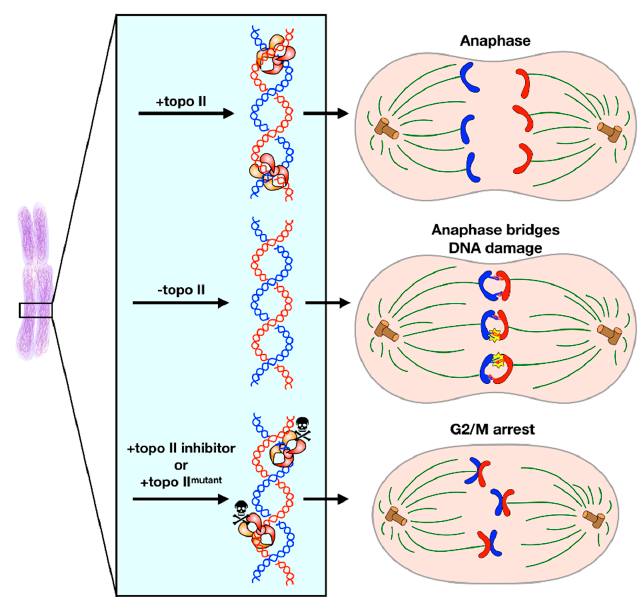
Figure 3. Decatenation Checkpoint. ( Upper ) Under normal conditions, topo II completes decatenation of intertwined sister chromosomes immediately before anaphase to allow for faithful chromosome segregation. ( Middle ) If topo II is absent, the cell cannot sense that sister chromosomes are catenated and will proceed into anaphase. Anaphase entry in this condition leads to the formation of anaphase bridges and DNA damage. ( Lower ) If topo II activity is inhibited by a small molecule or a mutation that impedes enzymatic activity, the cell will arrest in G2 / M phase until either decatenation is complete or the cell enters